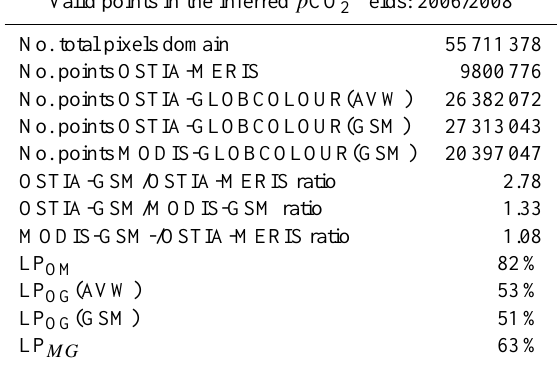
Figure 8. Spatial distribution of the time averages of p CO infer ues over the years 2006 and 2008 using (a) OSTIA SST and MERIS Chl a , (b) OSTIA SST and GSM-GLOBCOLOUR Chl a and (c) MODIS SST and GSM-GLOBCOLOUR Chl a . (d) Map with spa- tial distribution of the standard deviation for the p CO infer the different combination of the data sets. Table 3. Number of valid points in the p CO 2 fields and their differ- ence between the three combinations of MERIS or GLOBCOLOUR Chl with OSTIA or MODIS SST in the area of Benguela. Valid points in the inferred p CO 2 fields: 2006/2008